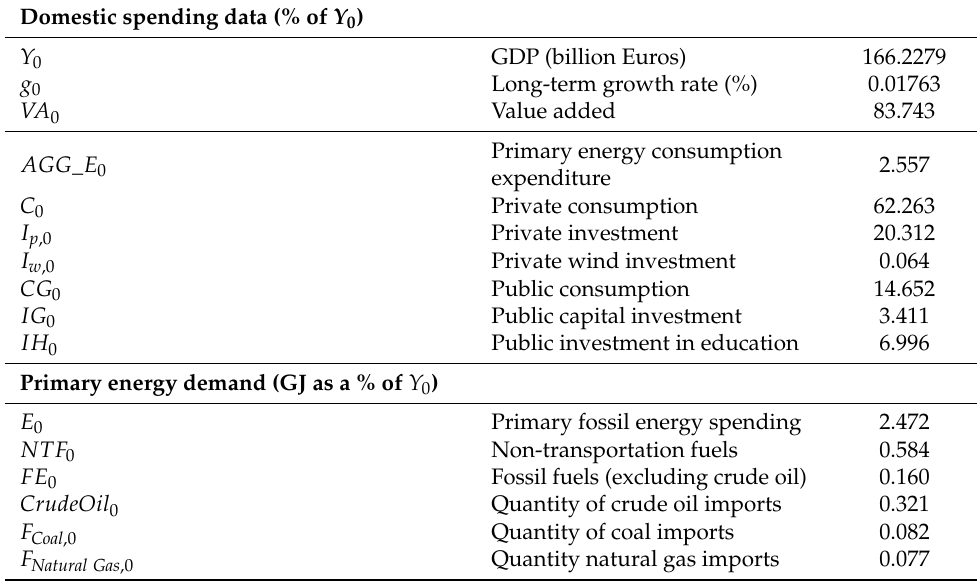
Table A2. The dynamic general equilibrium model—the basic data